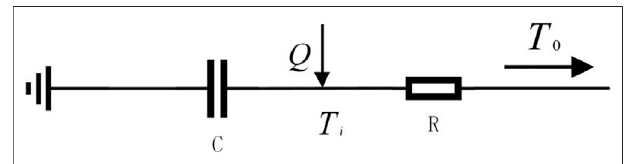
FIGURE 1 | ETP fi rst-order equivalent thermal parameter model